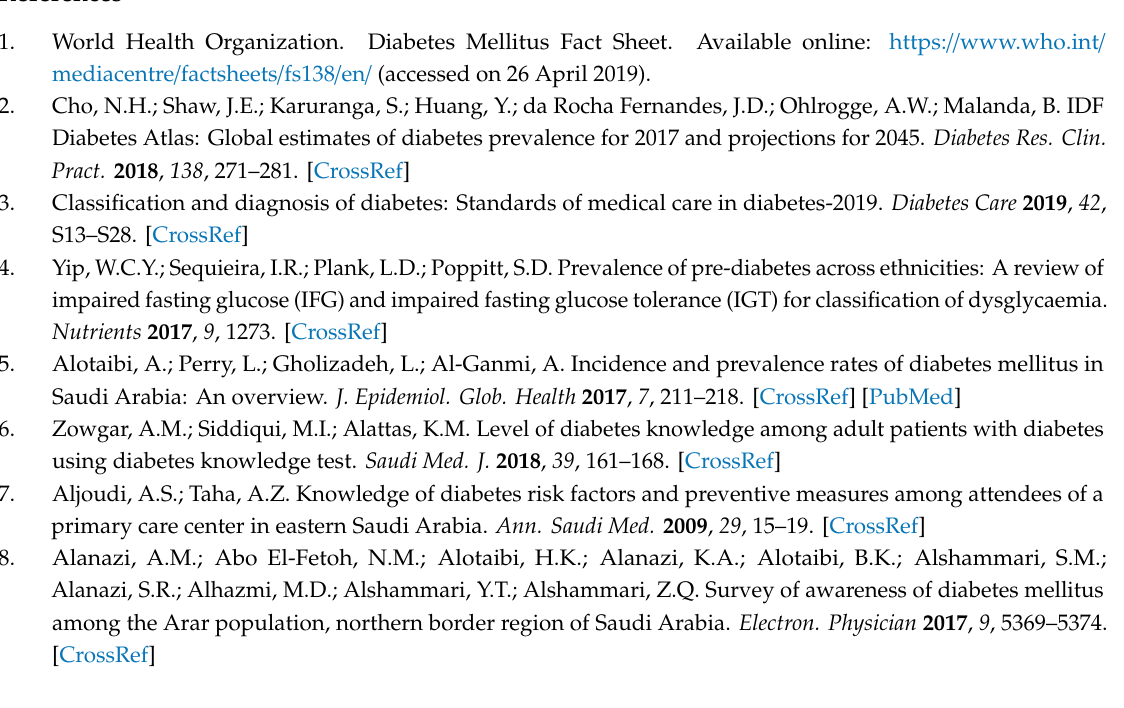
Table S1: Demographic and obstetric / gynaecological characteristics of all participants, along with the house hold income, current job and the educational level of the